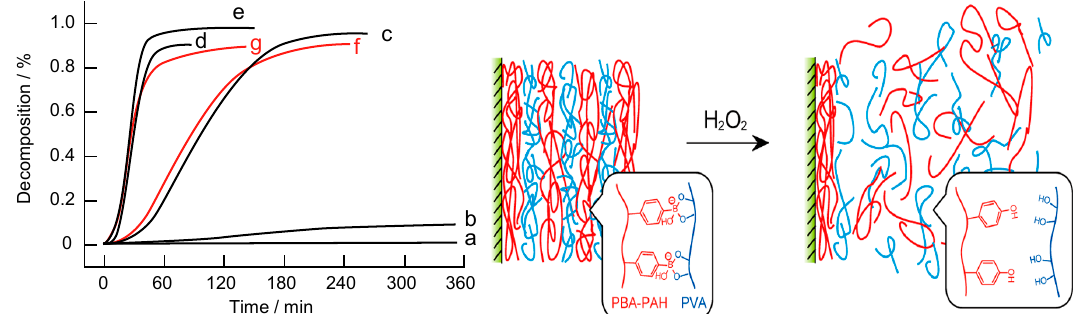
Figure 6. ( left ) Decomposition of (PBA-PAH/PVA) 10 film in the presence of H 2 O 2 at pH 7.4 (a–e), pH 6.0 (f), and pH 9.0 (g). H 2 O 2 concentrations were 0 (a), 0.05 (b), 0.1 (c), 0.5 (d), and 1.0 mM (e–g); ( right ) schematic illustration of the H 2 O 2 -induced decomposition of (PBA-PAH/PVA) 10 LbL film. Reprinted with permission from Ref. [60]. Copyright 2014 American Chemical Society.